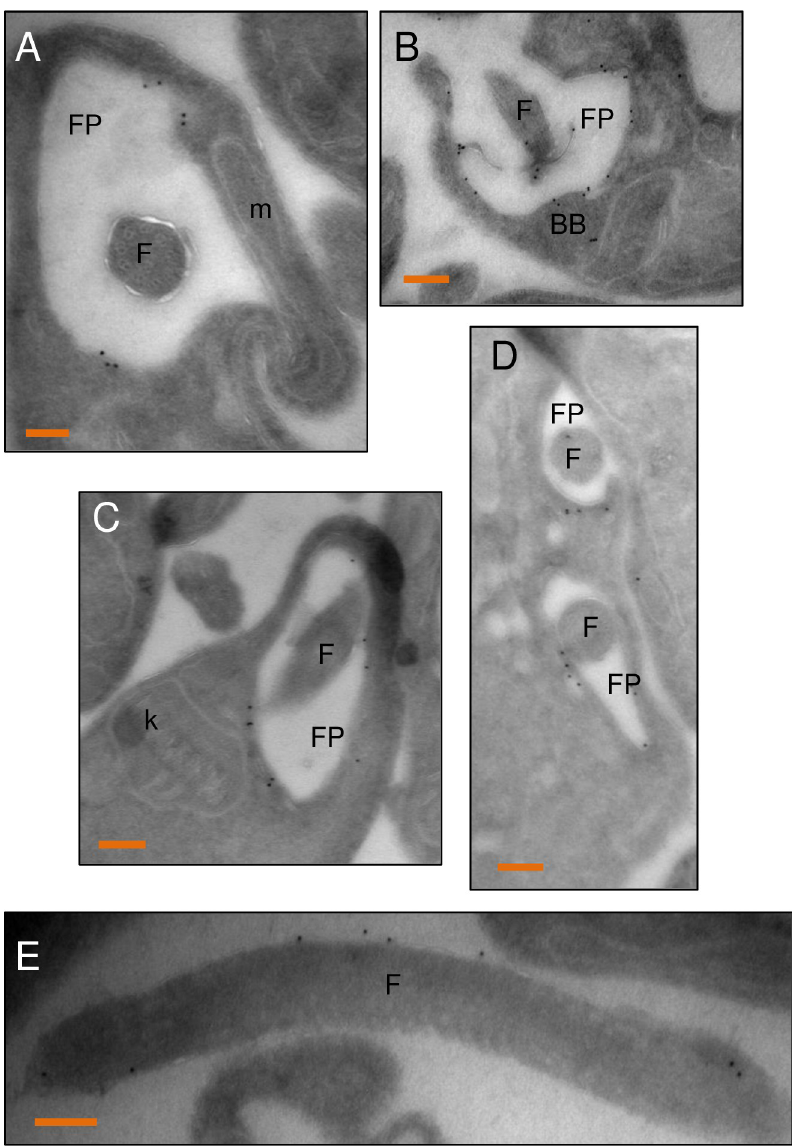
Fig 6. Localization of MEKK1-HA to the flagellum and flagellar pocket of procyclic forms by immunoelectron microscopy. PF expressing MEKK1 C-terminally tagged with HA epitopes were stained with anti-HA, and staining revealed by protein-A gold 10 nm particles. A) The gold staining is on the flagellar pocket (FP) membrane, flagellum (F), but absent from the mitochondrion (m). B) staining is observed at the base of the flagellar pocket at the basal bodies (BB). C) no staining of the kinetoplast (k) is seen. D) in a dividing cell, both flagellar pockets are stained. E) the external portion of the flagellum is also stained. Bars, 100